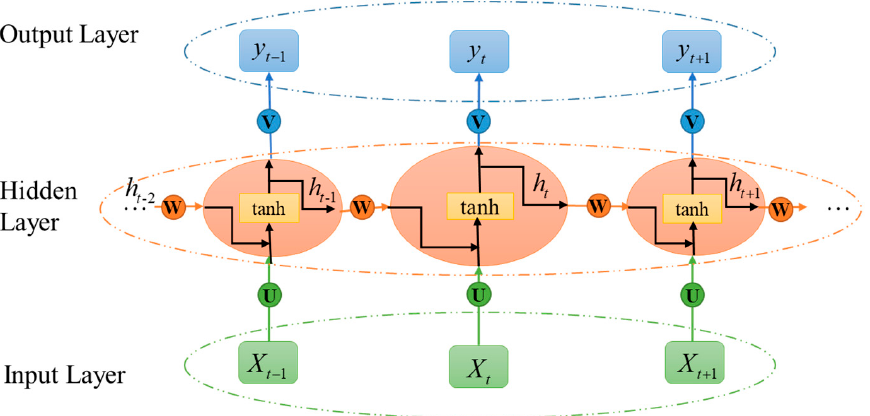
Figure 8. The general structure of the recurrent neural network (RNN). The LSTM has a memory cell that helps maintain long-term dependencies, as illus- trated in Figure 9. Three gates control this memory cell: input gate, forget gate, and output gate [43,54]. The state of the three gates is updated in each time step using the following equations Equations (15)–(17).